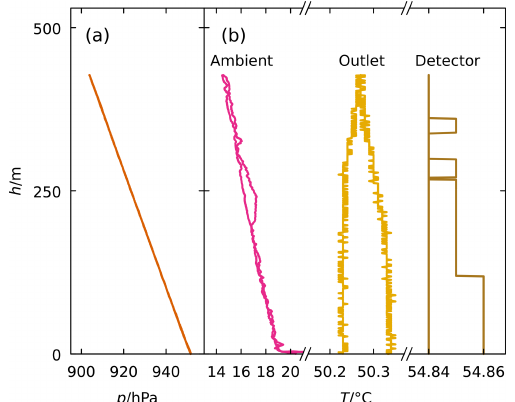
Figure 10. (a) CO 2 dry air mole fraction x CO of ambient air mea- Figure 11. Stability of COCAP’s internal temperatures during a 2 sured by COCAP and a CRDS analyser during a car drive. The flight to a maximum height of h = 430m above ground level. p three step-like patterns originate from the field calibration during is ambient pressure, T is temperature. Note the broken temperature which two gas standards are sampled. The peak at 09:16 occurred axis and the different scaling used for ambient, outlet and detector while waiting at a traffic light on a busy street. (b) Difference and smoothed difference of x CO measured by COCAP minus x CO 2 2 measured by the CRDS analyser. The smoothing is implemented by convolution with a Gauss window of 200s full width at half maxi- mum. The measurements of both analysers have been corrected us- ing the field calibrations and the flushing times have been equalised as explained in the text.